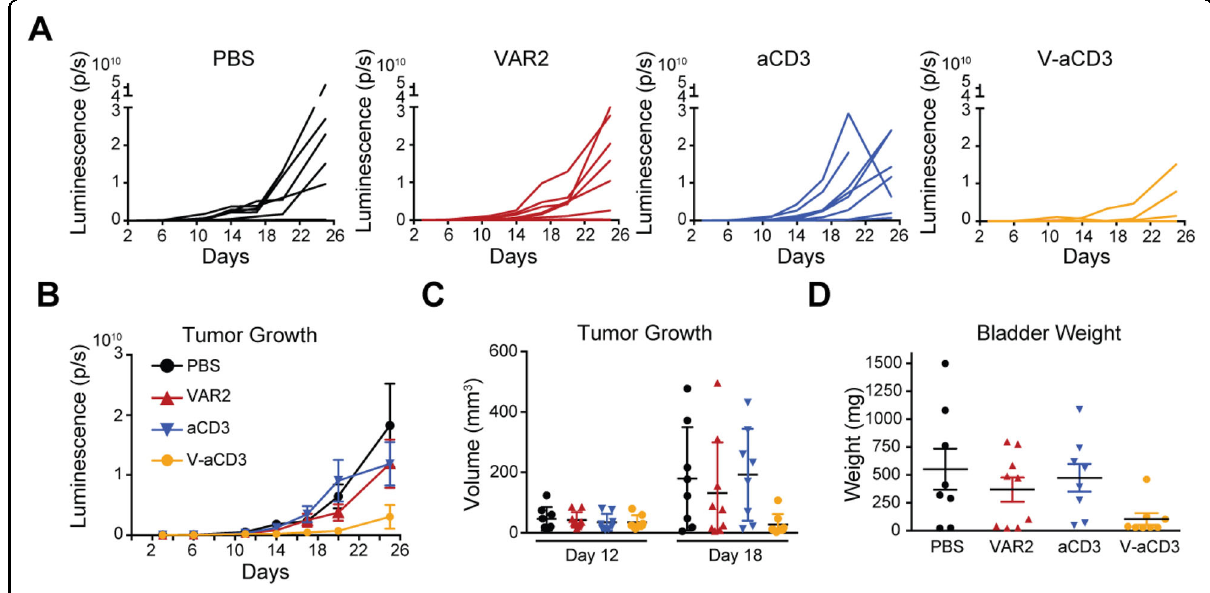
Fig. 5 V-aCD3 impedes growth of cancer cells in vivo in an orthotopic mouse bladder cancer model. A Tumor size (bioluminescence signal in bladder from cancer cells). Mice were transfused with human PBMC on days 0 and 5 after tumor injection and received treatment with V-aCD3 (solid black line), aCD3-scFc (green line), rVAR2 (dashed black line), or PBS (red line). Tumor growth was statistically signi fi cantly impeded in mice treated with V-aCD3 compared to mice treated with PBS, rVAR2, or aCD3-scFc ( P < 0.006, generalized least square model for log transformed panel data). B Tumor size of individual mice in the four groups, error bars are SEM of 8 – 9 mice. C Tumor size (mm3) measured by ultrasound on day 25. The tumor size of mice treated with V-aCD3 were statistically signi fi cantly lower than in mice treated with PBS or aCD3-scFc ( P = 0.028 and P = 0.006, respectively, Wilcoxon test). D Bladder weight including the tumor volume measured when mice were sacri fi ced on day 25. The bladder weight of mice treated with V-aCD3 were statistically signi fi cantly lower than in mice treated with PBS or aCD3-scFc ( P = 0.035 and P = 0.048, respectively, Wilcoxon